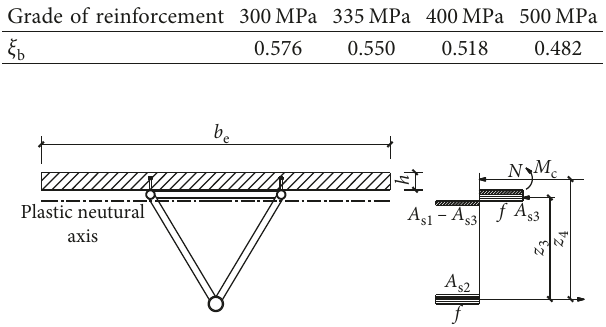
Table 3: Limit of the neutral-axis depth factor.